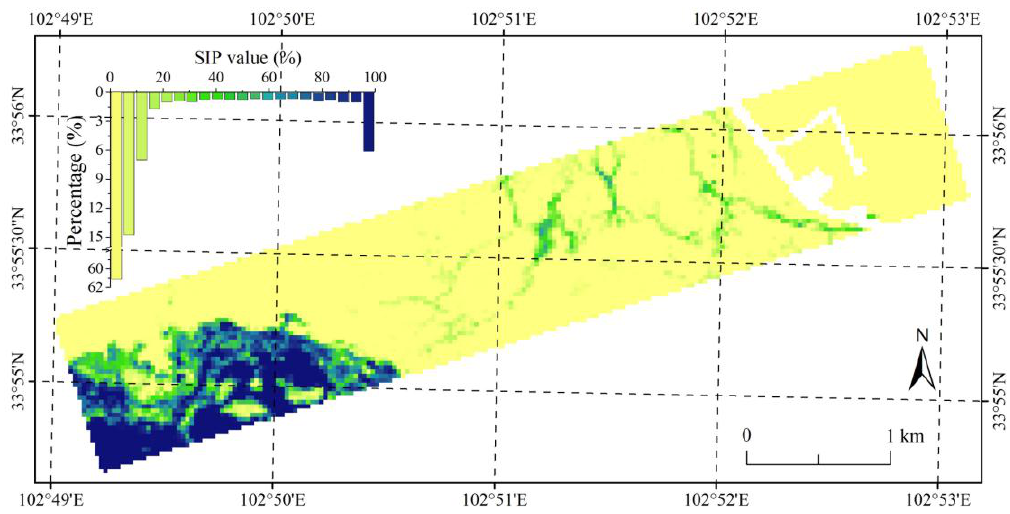
Figure 7. The reference SIP map of the transect in 2014 derived from the UAV classification map.